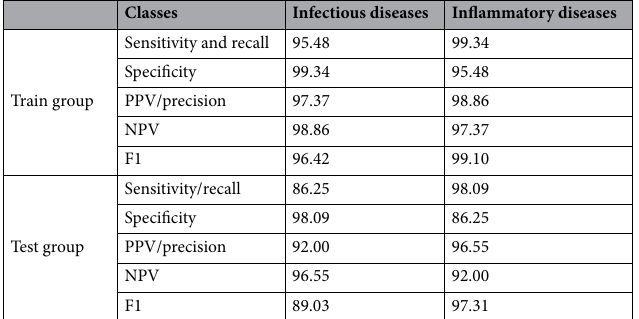
Table 4. Effects of AI prediction between train and test groups among various diseases in Project 2 (%). PPV positive predictive value, NPV negative predictive value.